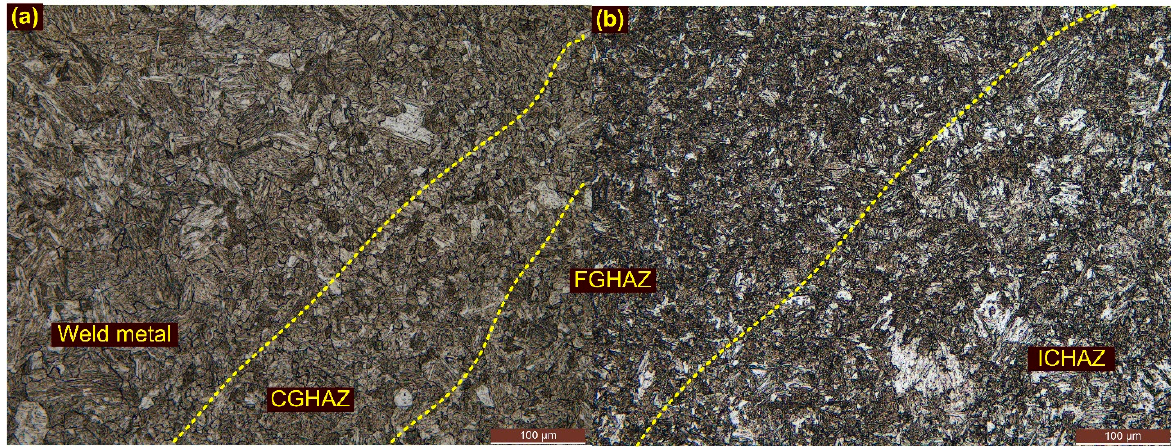
Figure 8. ( a ) Interface of the WFZ and CGHAZ; ( b ) interface of the FGHAZ and ICHAZ.